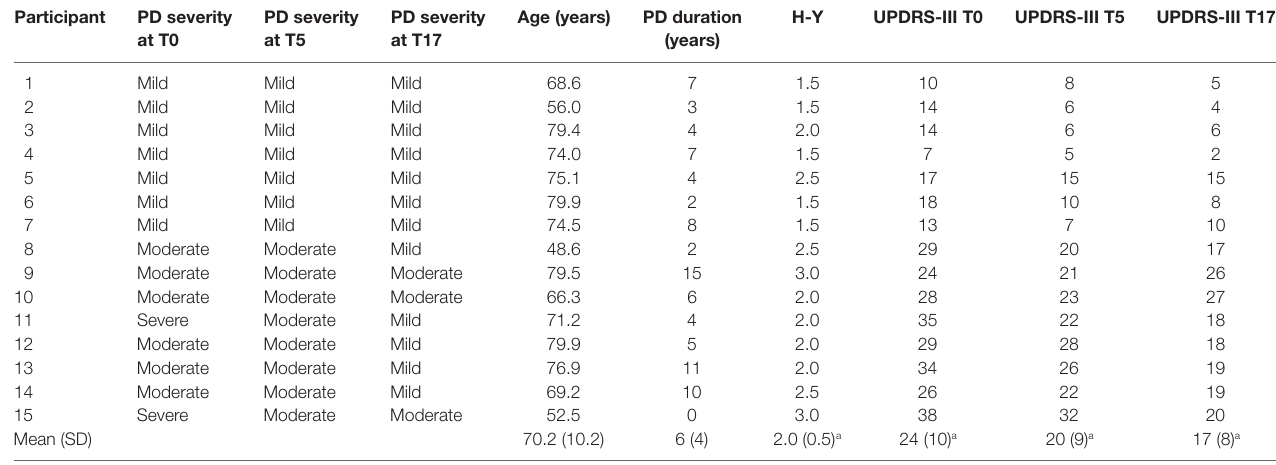
TaBle 1 | Features of the 15 persons with Parkinson’s disease (PD) at pre-program (T0), post-supervision (T5), and follow-up